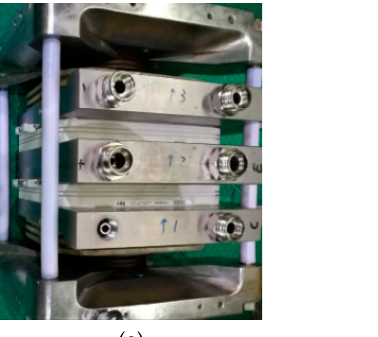
Figure 6. Double-sided cooling configuration: ( a) Mechanical press-pack stack; ( b ) Internal structure of heatsink.